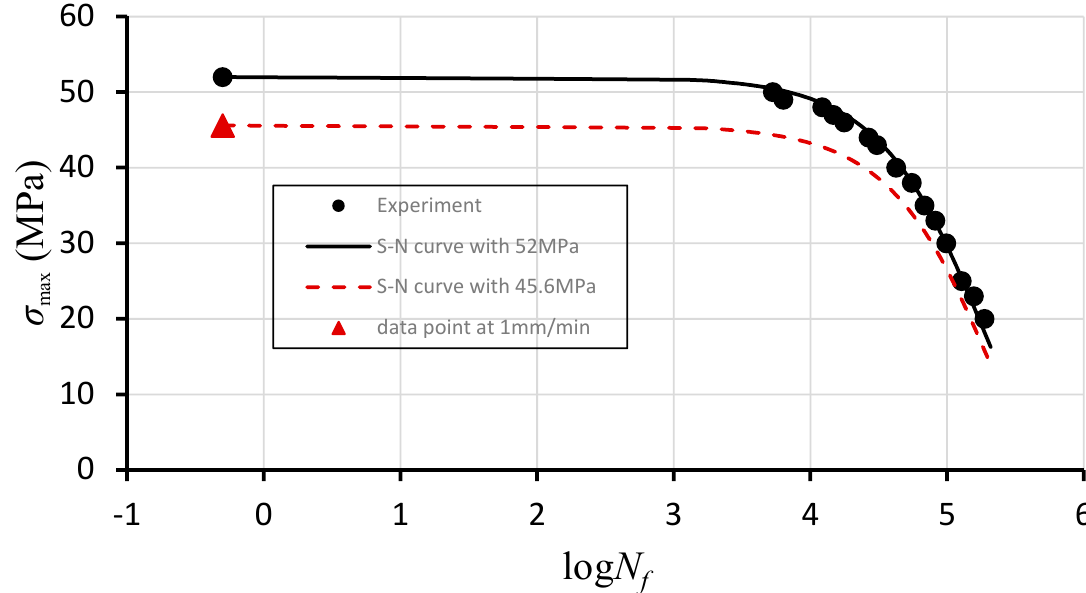
Figure 8. S-N curves fitted and experimental data: log α = − 7.016 and β = 1.031 for solid line with σ u = 52.0 MPa obtained from the extrapolation; and log α = − 6.707 and β = 0.856 for dashed line with σ u = 45.6 MPa obtained at a crosshead speed of 1 mm/min.